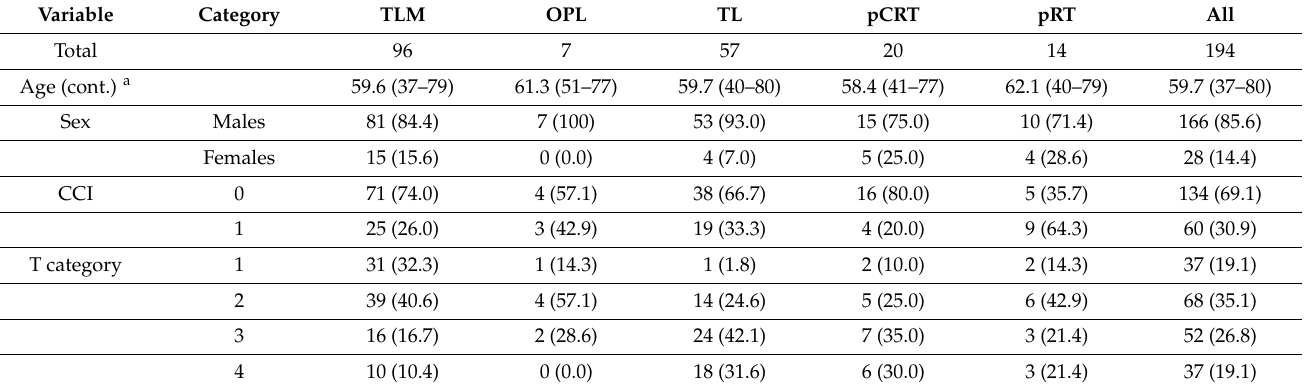
Table 1. Demographic and clinical characteristics of 194 supraglottic cancer